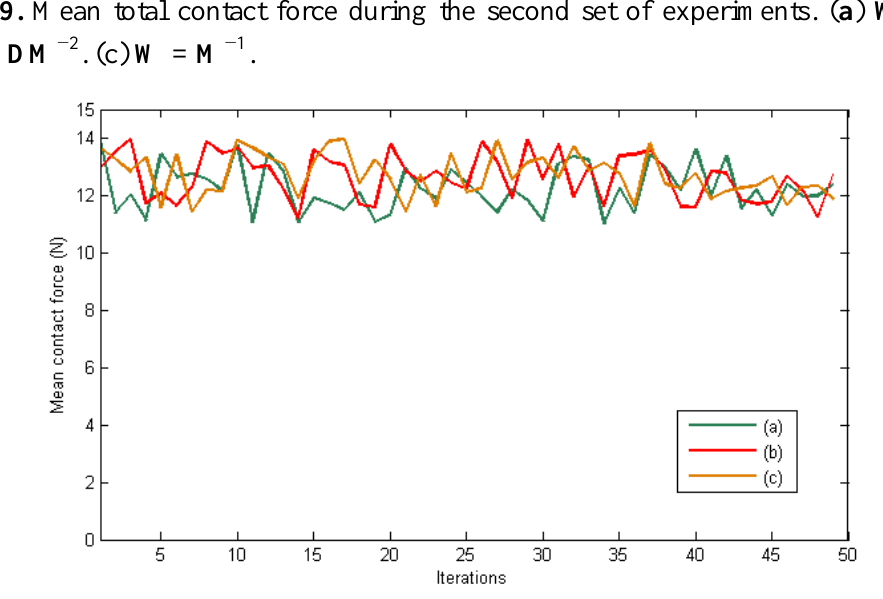
Figure 9. Mean total contact force during the second set of experiments. ( a ) W = M −2 . ( b ) W = DM −2 . (c) W = M −1